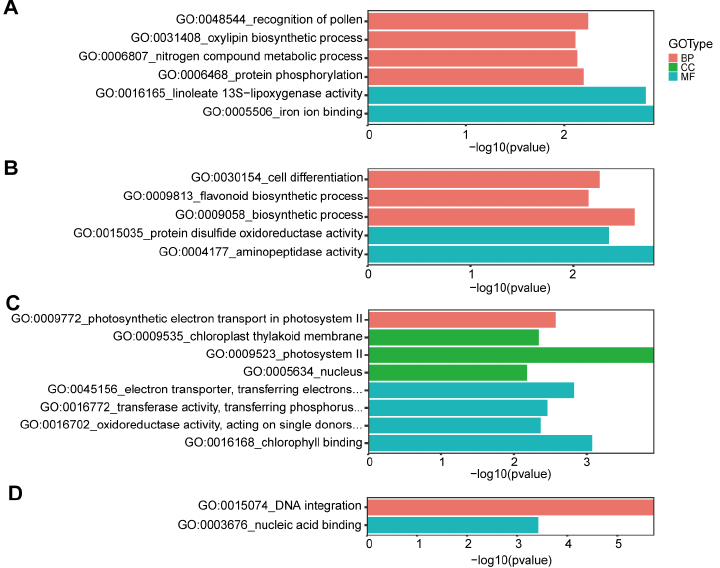
Figure 8. GO enrichment of the genes with the non-synonymous and stop-gain variations in Longli-4 and CA3-1. ( A – C ) GO terms of the non-synonymous genes specific in Longli-4 ( A ), in CA3-1 ( B ), and shared between Longli-4 and CA3-1( C ). ( D ) GO terms of the stop-gain genes specific in CA3-1.